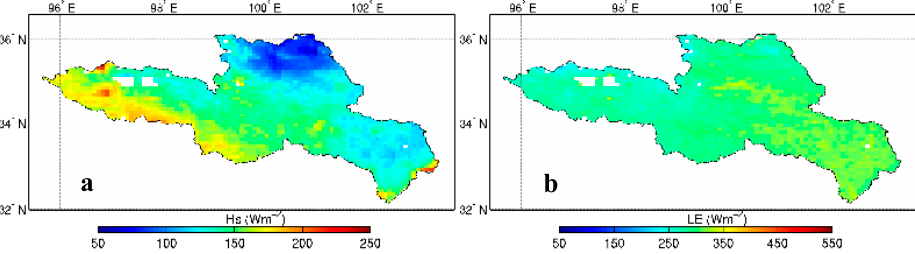
Figure 4. ( a ) Sensible heat flux from FY-2G and FY-3C (at Beijing time 15:40). ( b ) Latent heat flux from FY-2G and FY-3C (at Beijing time 15:40).